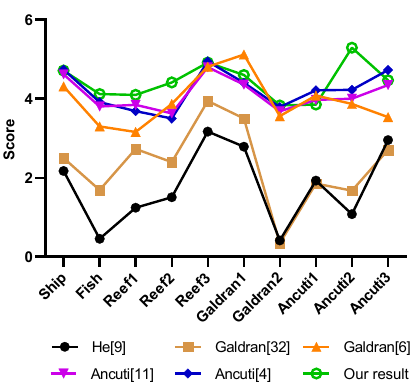
Figure 9. UIQM metric.